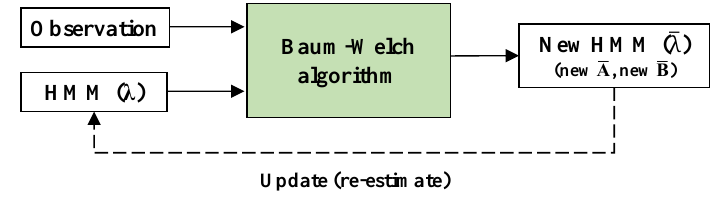
Figure 6. HMM updating using the Baum – Welch algorithm.